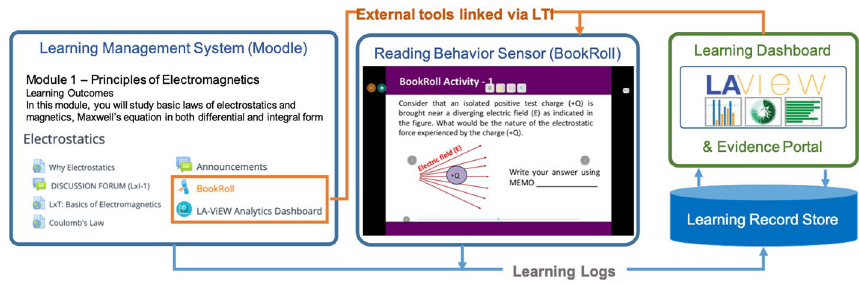
Fig. 2 Components of TEEL framework in this study (Kannan et al.,